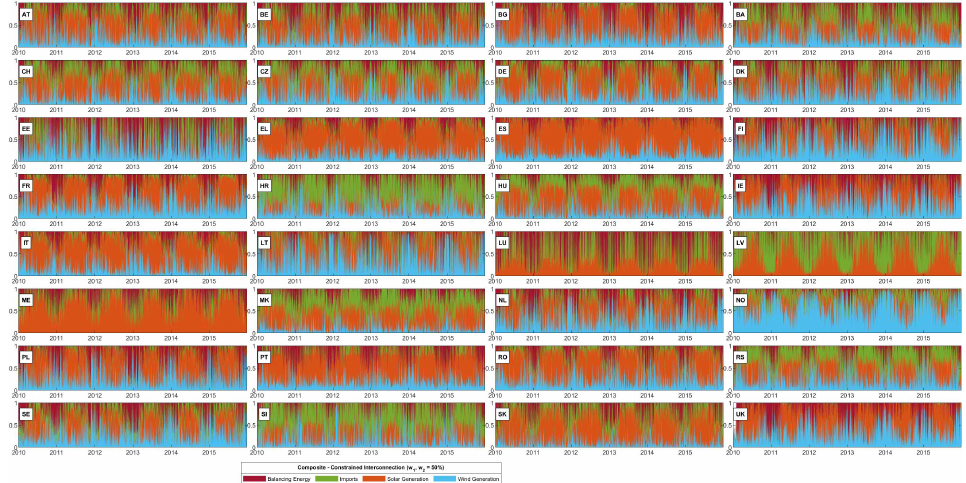
Figure 11. Left-hand side variables of the energy balance (Equation (1c)) for the case of the composite power